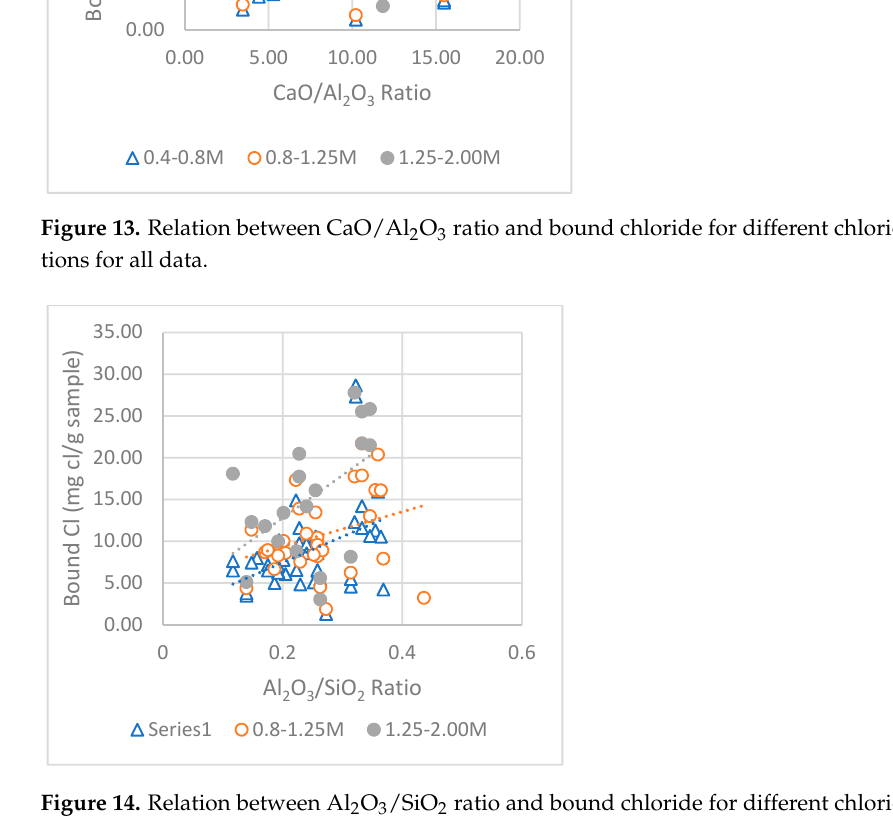
Figure 15. Bound Chloride versus free chloride for different CaO/SiO 2 ratios.